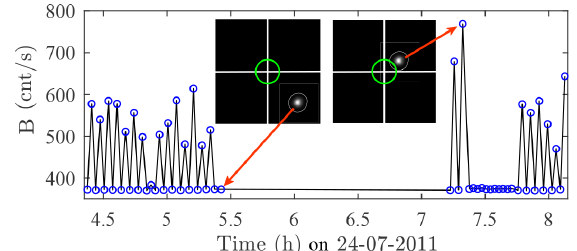
Figure 22. Starspot contamination of the background mea- surements (spikes) observed during the Halifax campaign with SPST05/M703. The spikes occur when background measurements are acquired too close to the star. The 1% star flux level (white cir- cles around the starspots) should never foul the photometer FOV (green circles).